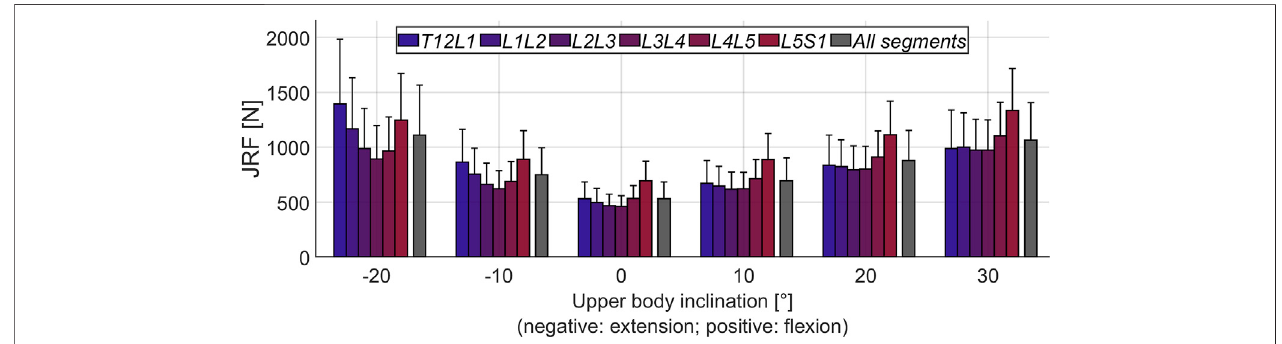
Frontiers in Bioengineering and Biotechnology |